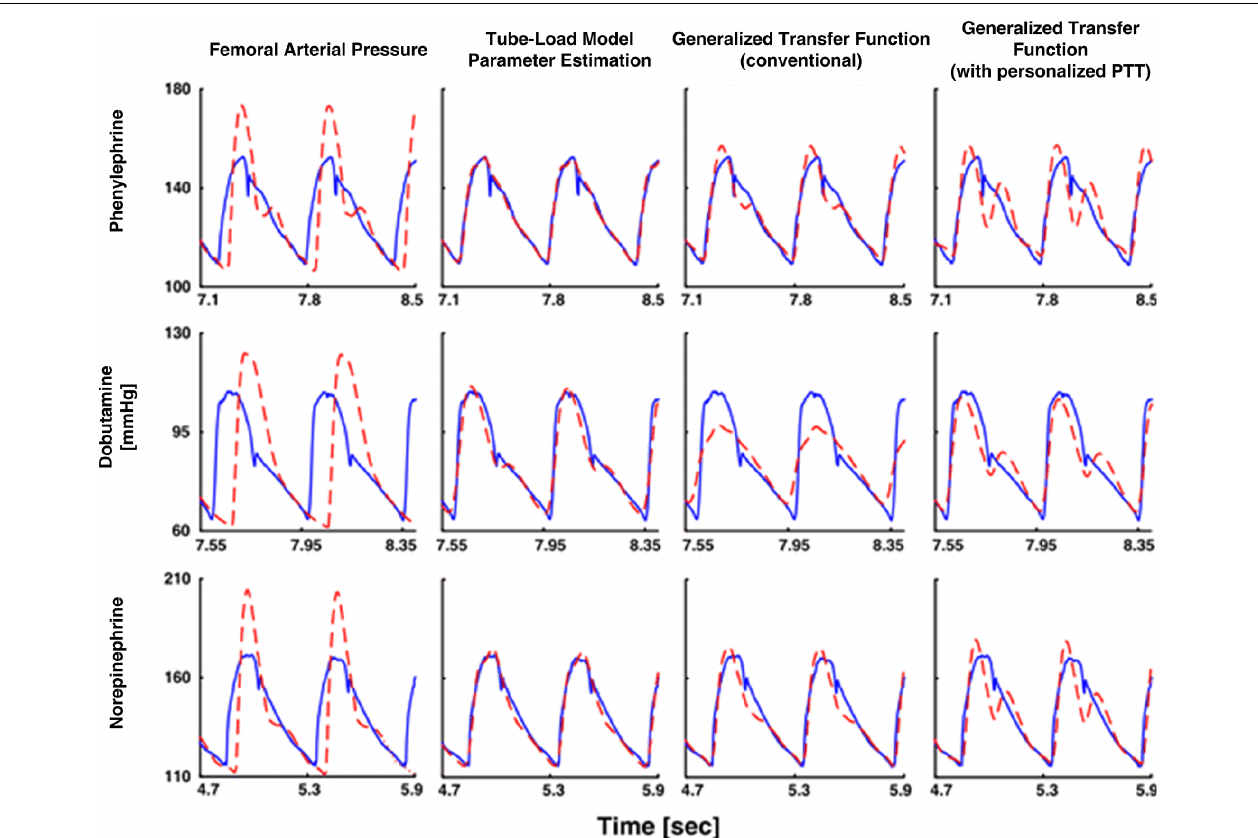
FIGURE 11 | Central aortic pressure waveforms measured (solid) and derived from a femoral arterial pressure waveform (dash). Adapted from Swamy et al.